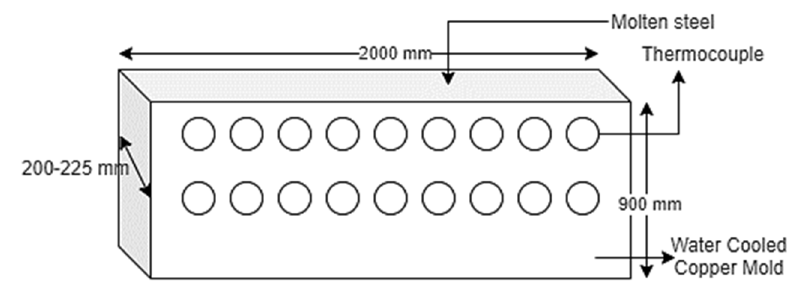
Figure 1. Copper mold for continuous casting at Bokaro Steel Plant.